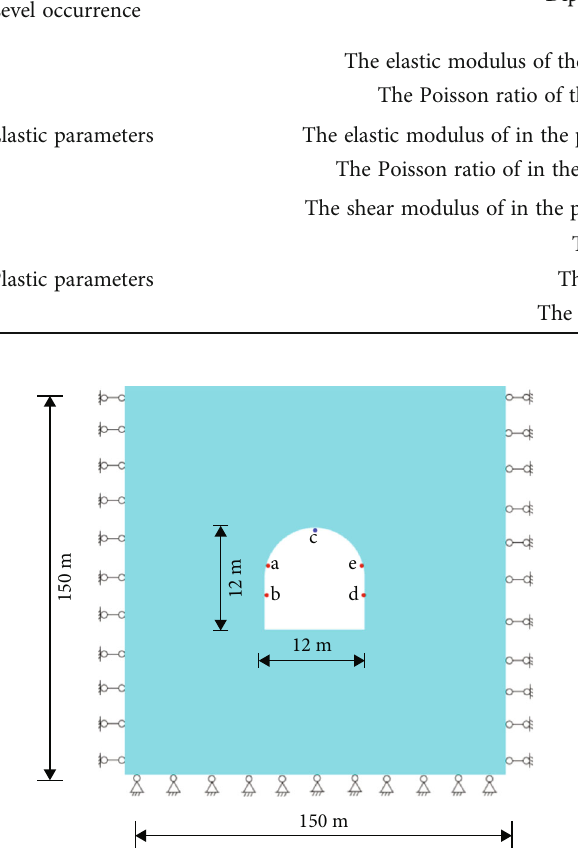
Figure 5: Geometric sizes and boundary conditions of the